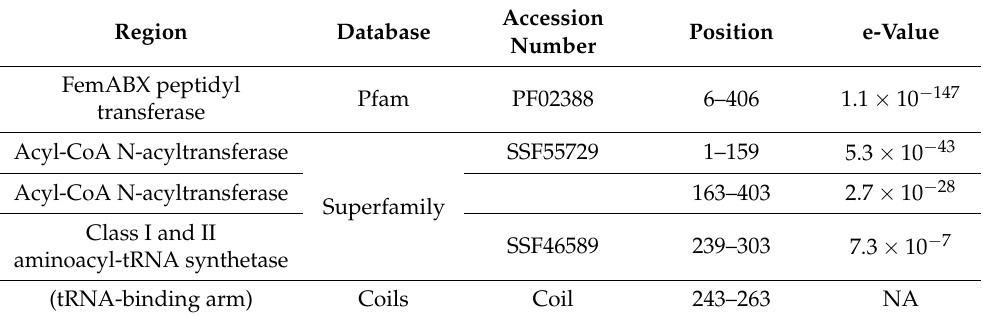
Table 10. Protein family regions identified by the InterPro LGMAI’s putative Zif sequences